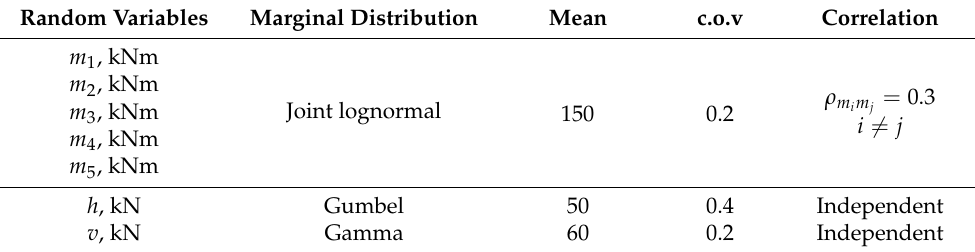
Table 10. Target failure probability and parameters for the reliability analysis and optimization.